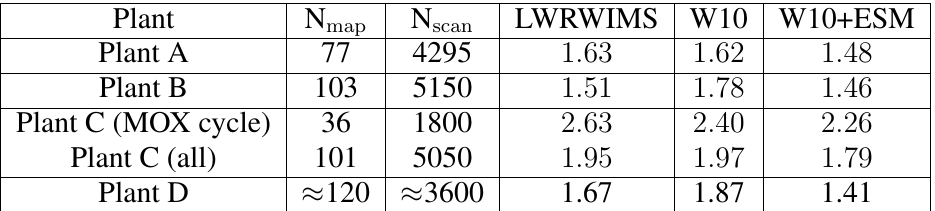
Table III: Percentage RMS Error in Prediction of Axially Integrated Reaction Rates Plant N map N